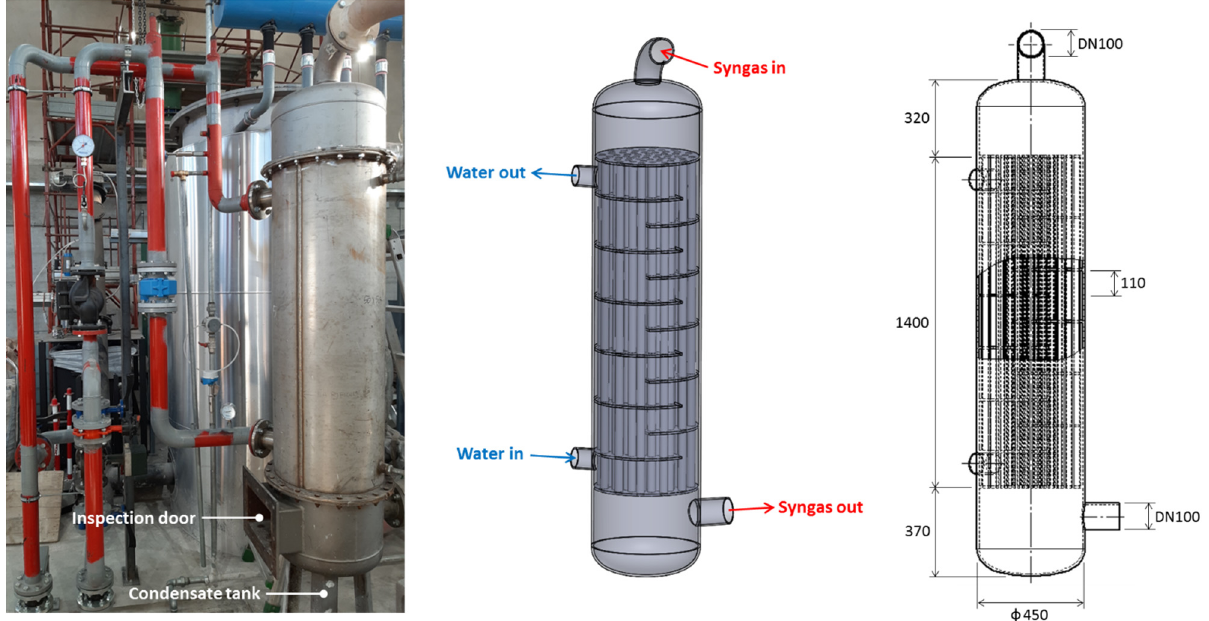
Figure 2. Shell-and-tube heat exchanger for syngas cooling: actual geometry and reconstructed three-dimensional model.